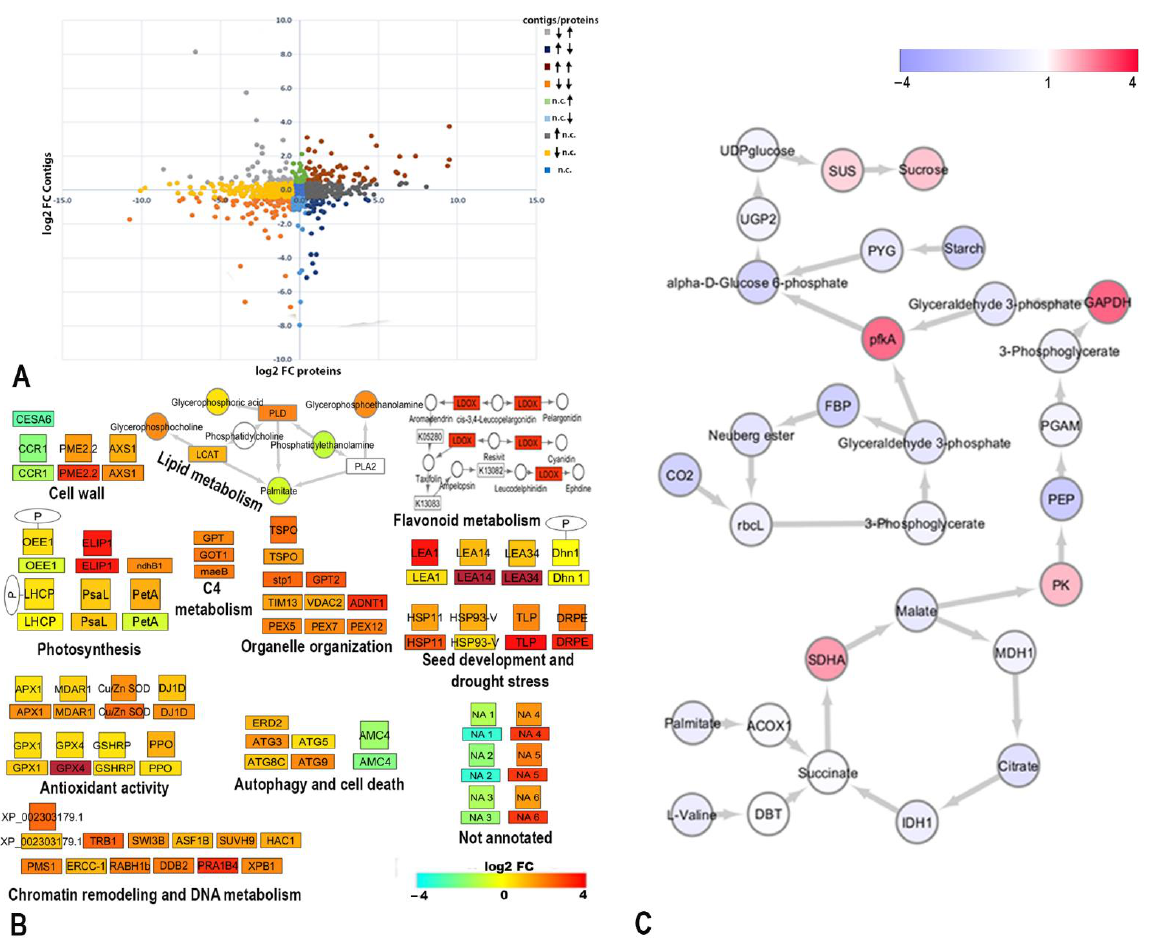
Figure 5. Pathway analysis and co-expression changes in the proteome and transcriptome of H. rhodopensis . ( A ) Scatter plot of averaged log2 transformed fold changes of abundances of RNA contigs ( x -axis) and the corresponding proteins ( y -axis). Colored bar represents significant expression changes above log2 of 0.5 for contigs and proteins (n.c. — no change; arrow up — upregulation; arrow down — downregulation). ( B ) RNA contigs and peptides annotated in the CLUE GO network were searched against the KEGG database and visualized together with available metabolomic data to clarify their involvement in cellular metabolism. Squares represent assigned proteins, rectangles represent transcripts, and circles represent metabolites. The colored bar represents changes in log 2 FC between plants in the fresh and dry states. P — phosphorylation event. ( C ) Pathway signal flow analysis. The pathway was constructed by condensing and enriching a subset of reactions from several primary metabolism pathways of A. thaliana downloaded from KEGG. Unidirectional edges were used for reactions. Nodes are colored from blue to red, corresponding to low to high signals, respectively. The median was regarded as one because it represented the normal state.